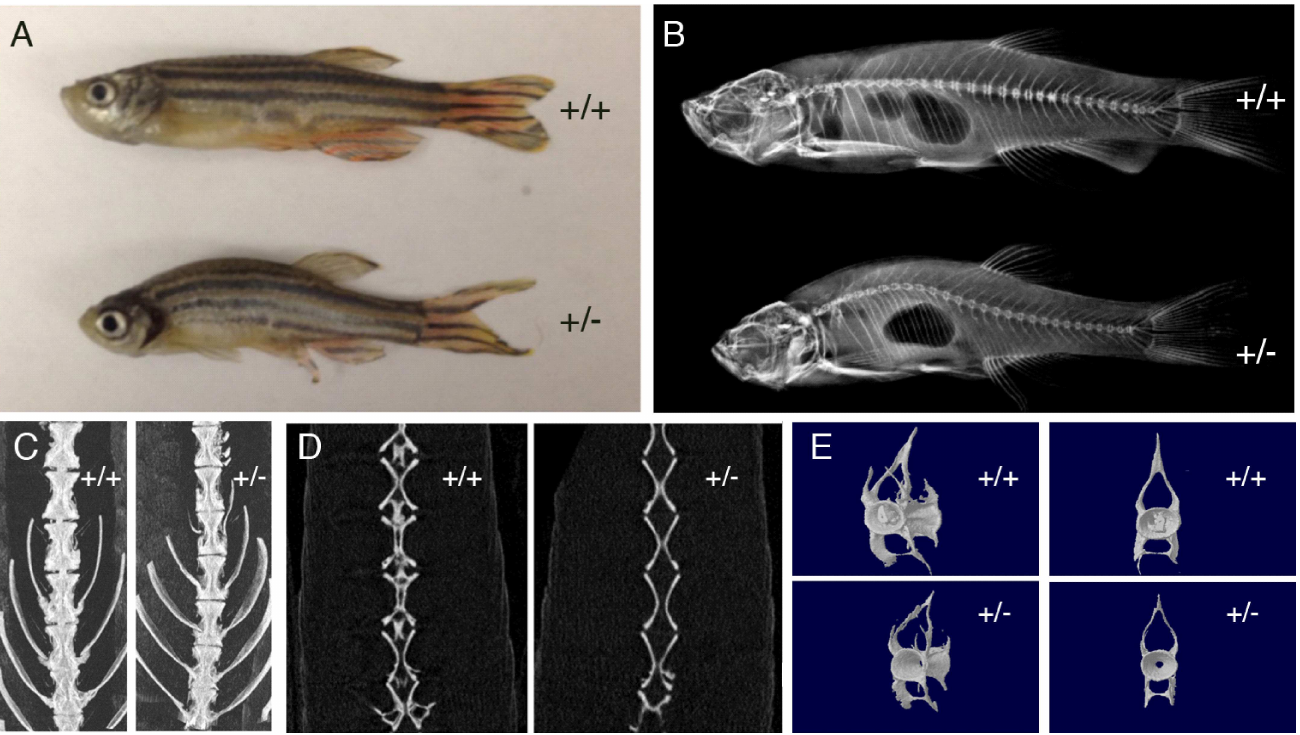
Fig 3. Micro-computed tomography scan of adult zebrafish. Adult zebrafishheterozygous for atp6V1h mutation (+/-) show curved body, compared to the wild type (+/+) sibling( A ). X-ray of the same +/- fish shows curved spine comparedto the +/+ sibling( B ). Vertebra of +/- fish has bristlier surface and smaller size ( C ). Vertebra of +/- fish lacks calcifiedstructure in the centrum cavity ( D ). Individual vertebra of +/- fish shows bristlier surface and smaller size with a hollowcentrum ( E ) (n = 3